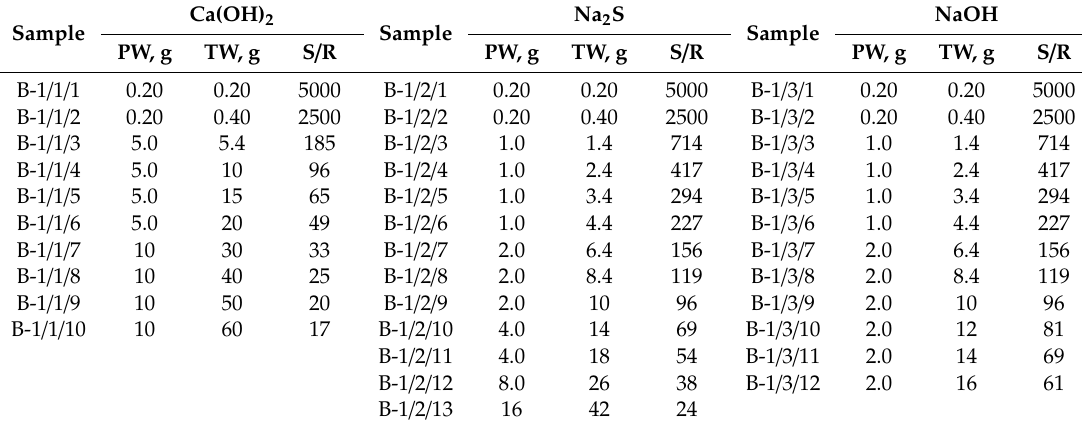
Table 2. The weight of the portion (PW, g), the total weight of the reagent (TW, g) and the ratios of the solution and the reagent (S / R) during the